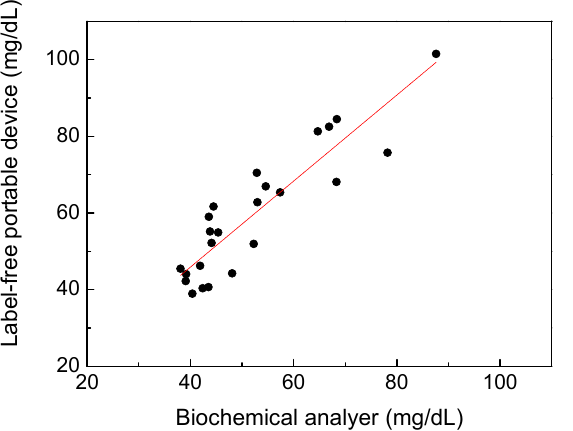
Figure 6. The uric acid concentration detection results using the label-free portable device with respect to the biochemical analyzer. The coefficient of determination is 0.8083.